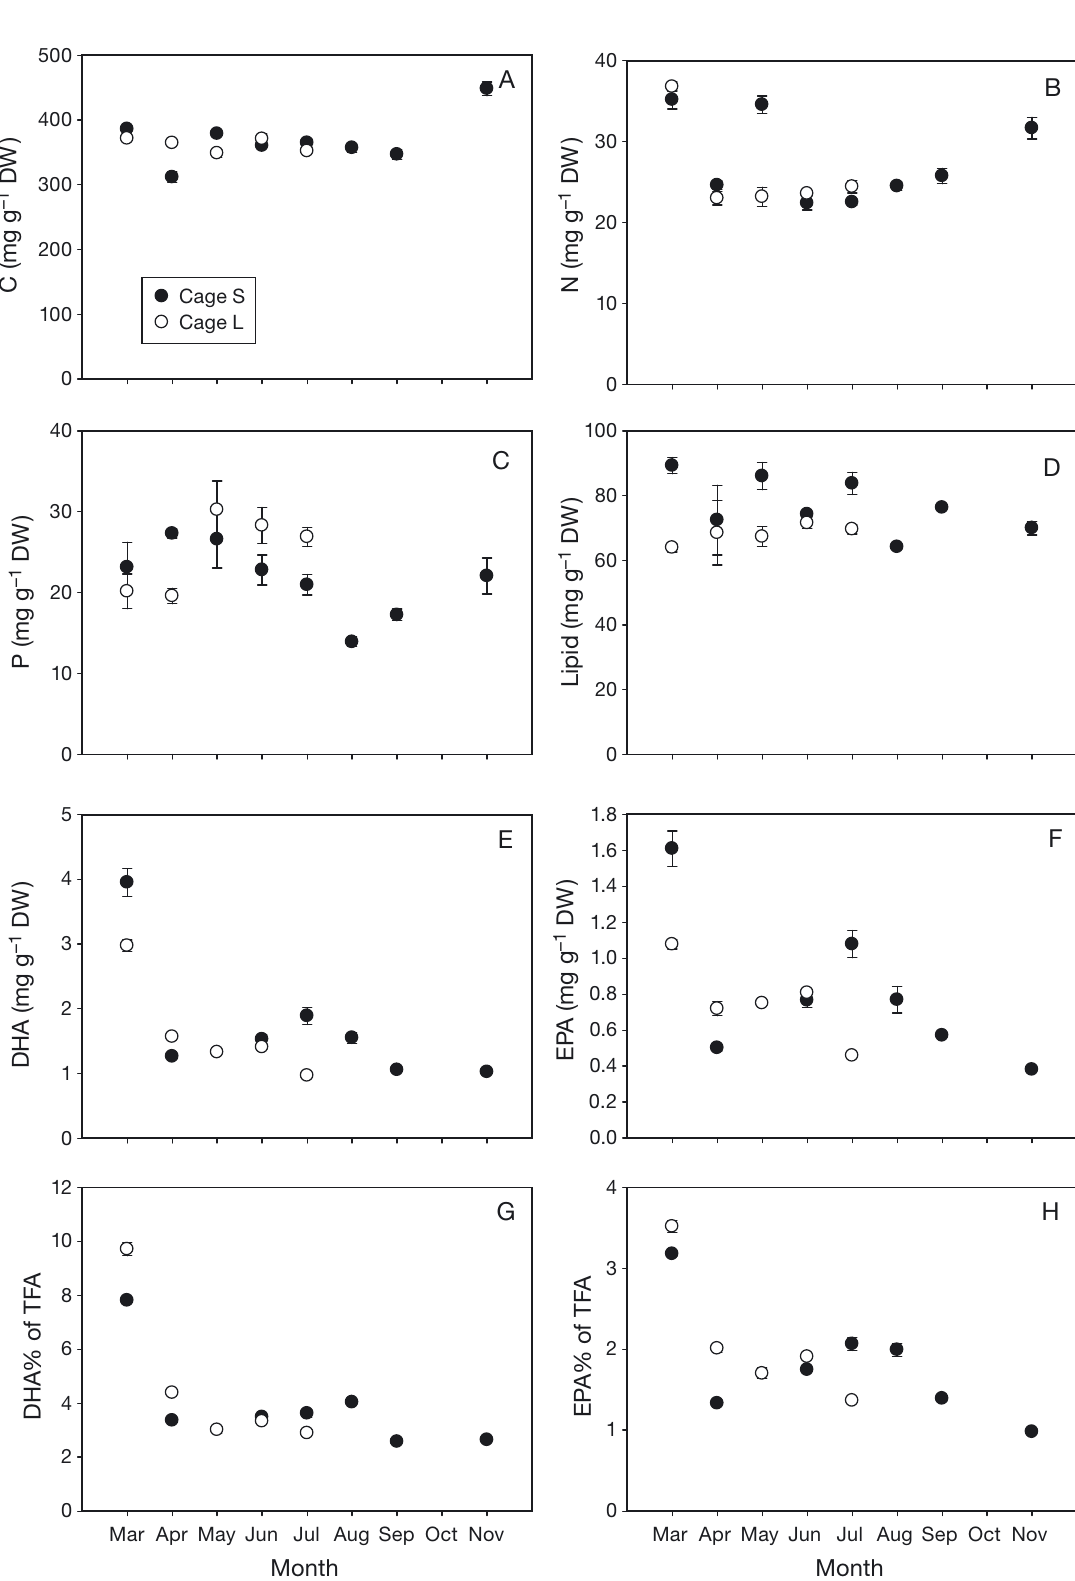
Fig. 7. Chemical contents per DW of faeces sampled from Cage S and Cage L. (A) Carbon; (B) nitrogen; (C) phosphorus; (D) lipid; (E) docosahexaenoic acid DHA; (F) eicosapentaenoic acid (EPA); (G) percentage of DHA in total fatty acid (TFA) content; (H) percentage of EPA in TFA content. Error bars show ±1